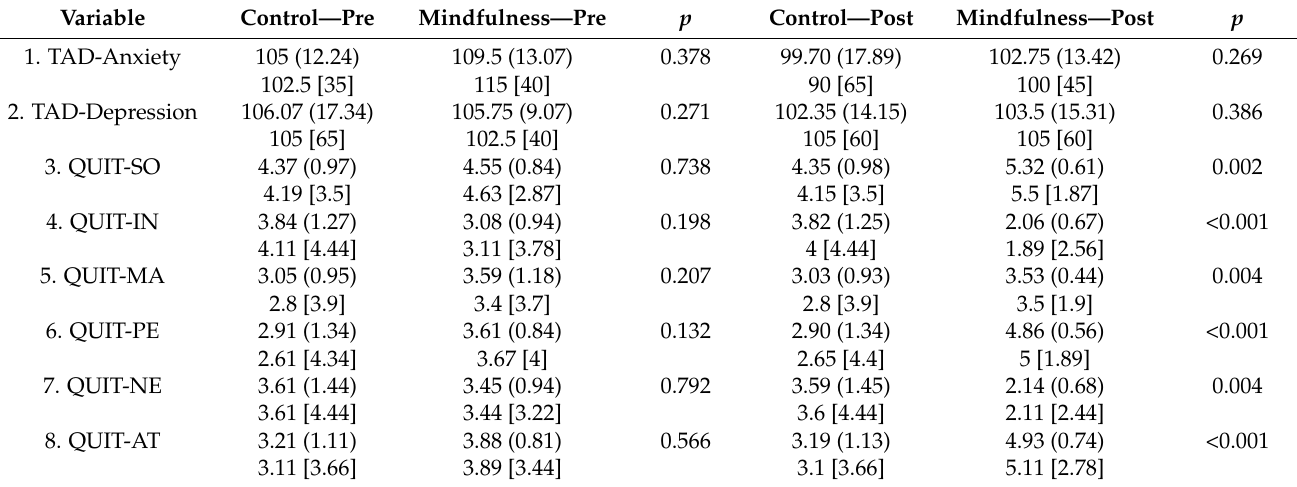
Table 1. Group comparisons among the study measures between Mindfulness ( n = 23) and Control ( n = 18) samples assessed pre-intervention and